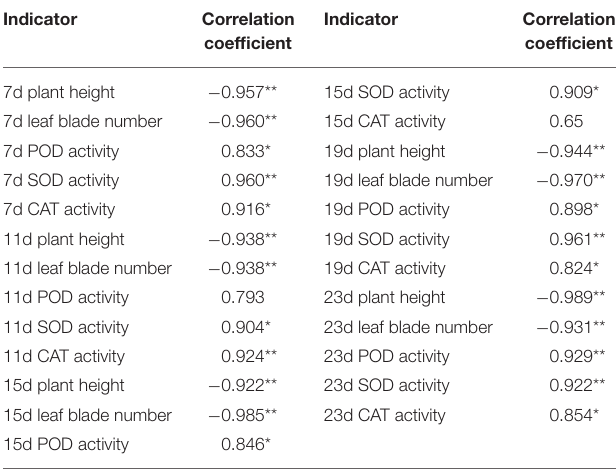
TABLE 1 | Correlation analysis in seedling stage. Indicator Correlation Indicator coefficient